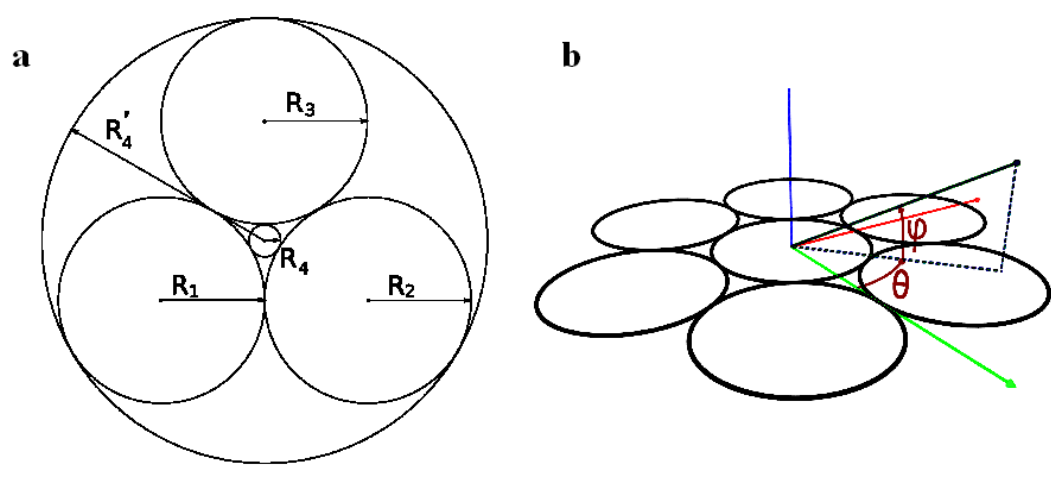
Figure 1. (a): three circles of radii R the particular case R initial circles; (b): coordinates system with the two angles, longitude θ and latitude ϕ